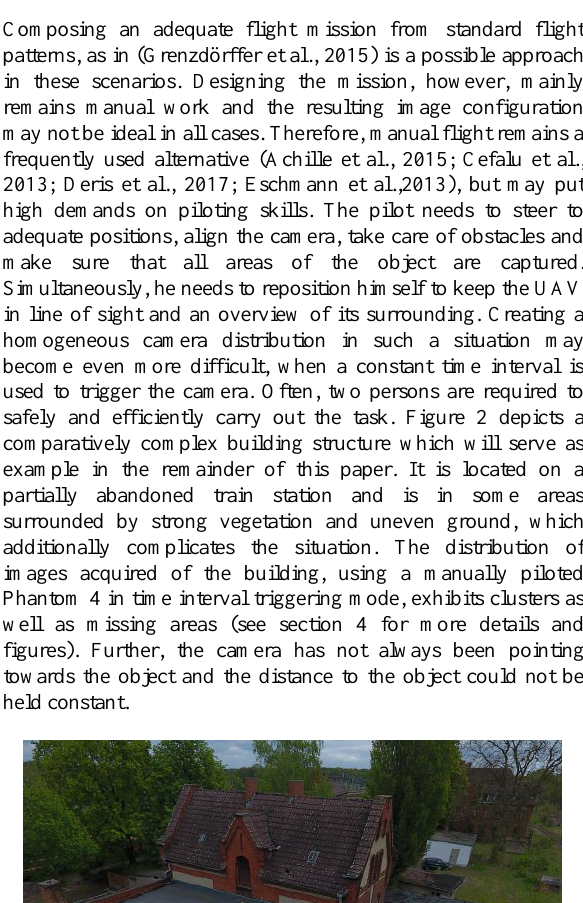
Figure 1. An off-road capable quad, equipped with a variety of sensors, is the core of terrestrial data acquisition and serves as a mobile workstation.